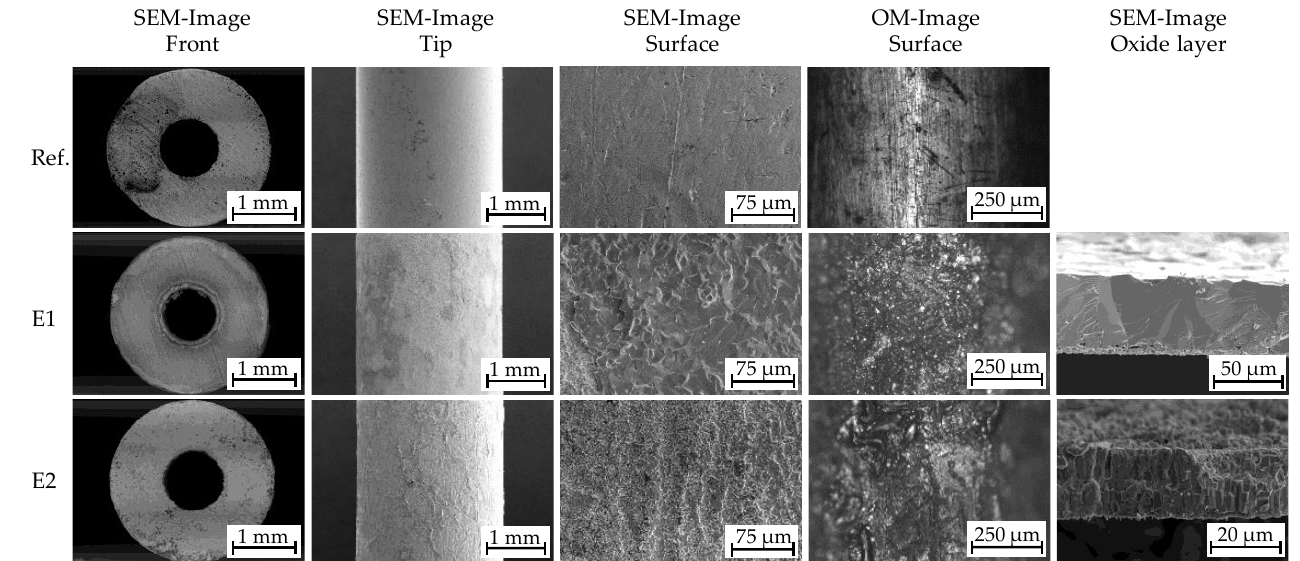
Figure 3. SEM and OM images of the reference and the oxidized tool electrodes. As indicated, the oxidation of the tool electrode resulted in an irregular oxide layer, shown by the darker areas at the tip of tool electrodes E1 and E2. The delamination of the oxide layer was also seen in the inner channel of tool electrode E1. Furthermore, increased surface roughness due to the nonuniform formation of oxides on the surface and thermal stress ( σ th ) caused by a difference in thermal expansion ( α ) between copper and its oxides was observed for the oxidized electrodes. The thermal stress ( σ th ) led to the partial delam- ination of the oxide layer, with an oxide layer thickness (d oxi ) of up to 60 µm caused by a difference in the thermal expansion coefficient between copper ( α Cu = 17.1 × 10 − 6 /K) and its oxides ( α CuO = 12.5 × 10 − 6 /K and α Cu2O = 2.8 × 10 − 6 /K) [24]. Therefore, it is reasonable to assume that the base material may have affected the results of the four-terminal measure- ment. In addition to cracks and irregular oxide layers, the thermal exposure also led to re- covery and recrystallization processes, which could explain the slight decrease in electrical resistivity ( ρ ). The recovery process resulted in the removal of defects and dislocations, whereas the recrystallization process led to the formation of a new micro-structure. The cho- sen oxidation temperature ( ϑ oxi ) and slower cooling in air also supported grain coarsening. Cross-sections of the tool electrodes are shown for comparison in Figure 4.